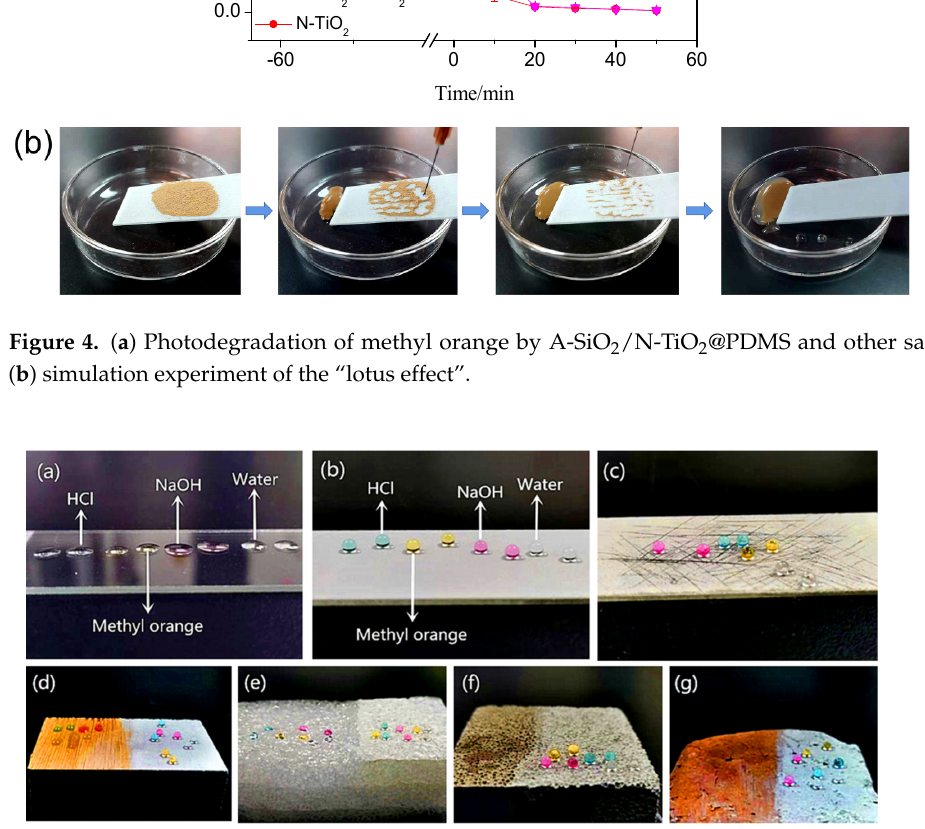
Figure 5. Wettability of the surfaces of ( a ) a glass slide, ( b ) the A-SiO 2 /N-TiO 2 @PDMS coating after UV irradiation, and ( c ) the mechanically damaged A-SiO 2 /N-TiO 2 @PDMS coating after UV irradiation to water, HCl, NaOH, and methyl orange solution droplets, respectively; wettability of the surfaces of ( d ) wood, ( e ) foam, ( f ) concrete, and ( g ) brick before (left) and after (right) being sprayed with A-SiO 2 /N-TiO 2 @PDMS and UV irradiation to water, HCl, NaOH, and methyl orange solution, respectively.